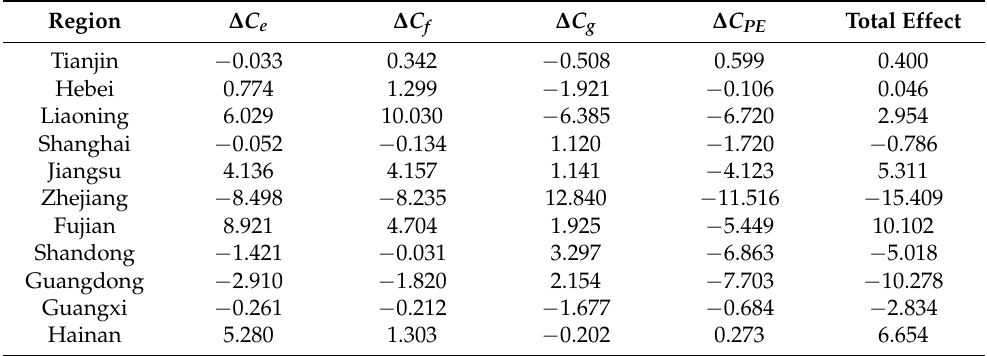
Table 3. Decomposition results of net carbon emissions from offshore fishing in China’s coastal provinces from 2010 to 2019 (10 4